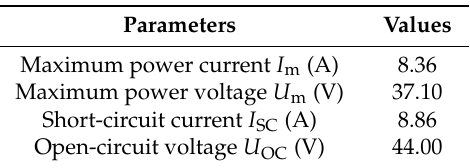
Table 1. The parameters of